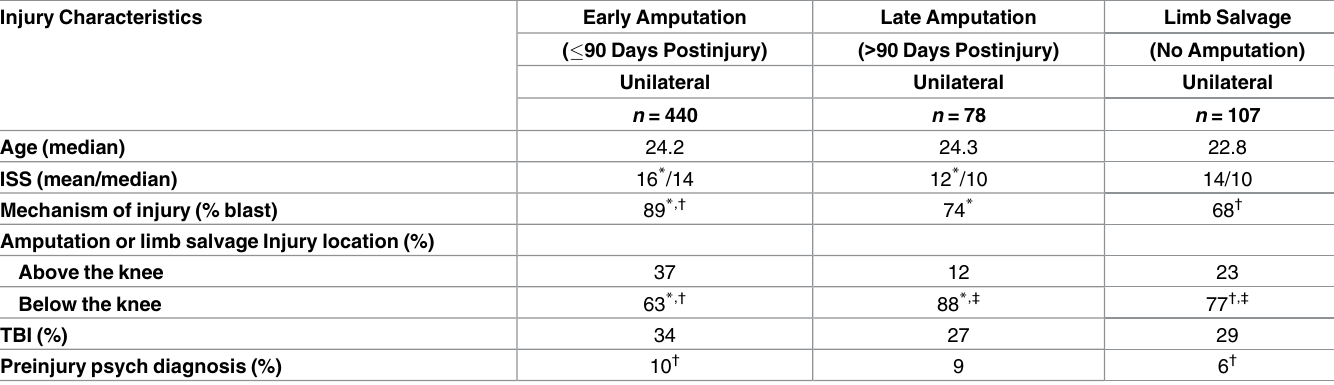
Table 1. Injury Characteristics of Patients who Underwent Amputation or Limb